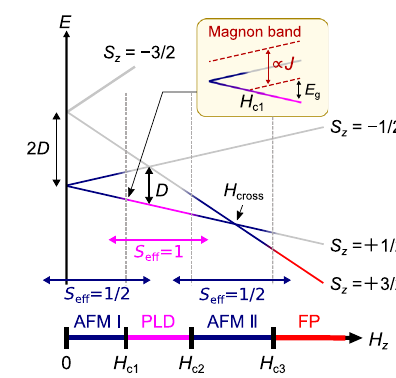
Fig. 1 | Double Bose – Einstein-condensation (BEC) dome in S =3/2 quantum width of magnon bands and critical fi elds, as schematically depicted in the inset. magnet. a Energy diagram of the S =3/2 spin site with easy-plane type single-ion Each fi eld region can effectively be described by spin Hamiltonian for S eff =1/2 or (SI) anisotropy D ^ S 2 z ð D >0 Þ in a magnetic fi eld along the z -direction. The ground S eff =1 [see the discussion on Fig. 5d for the latter]. b Schematics of the phase (cid:4) (cid:4) in AFMI phase, and ∣ S z =1 = 2 state mainly consists of single-site states ∣ S z = ±1 = 2 diagram for three different strengths of J (>0). In a weakly interacting regime, two (cid:4) and ∣ S z =3 = 2 inAFMIIphase,indicatedbythedarkbluecoloredline.Above H c3 ,as well as between H c1 and H c2 , the ground state is a direct product of the single-site (cid:4) (cid:4) and ∣ S z =3 = 2 , respectively), indicated by low temperature, as depicted by the light-blue color. Finally, in the strongly inter- ground state at that fi eld (i.e., ∣ S z =1 = 2 the pink and red-colored lines. Antiferromagnetic interaction J (>0) determines the acting regime, two domes merge entirely, indicated by the gray